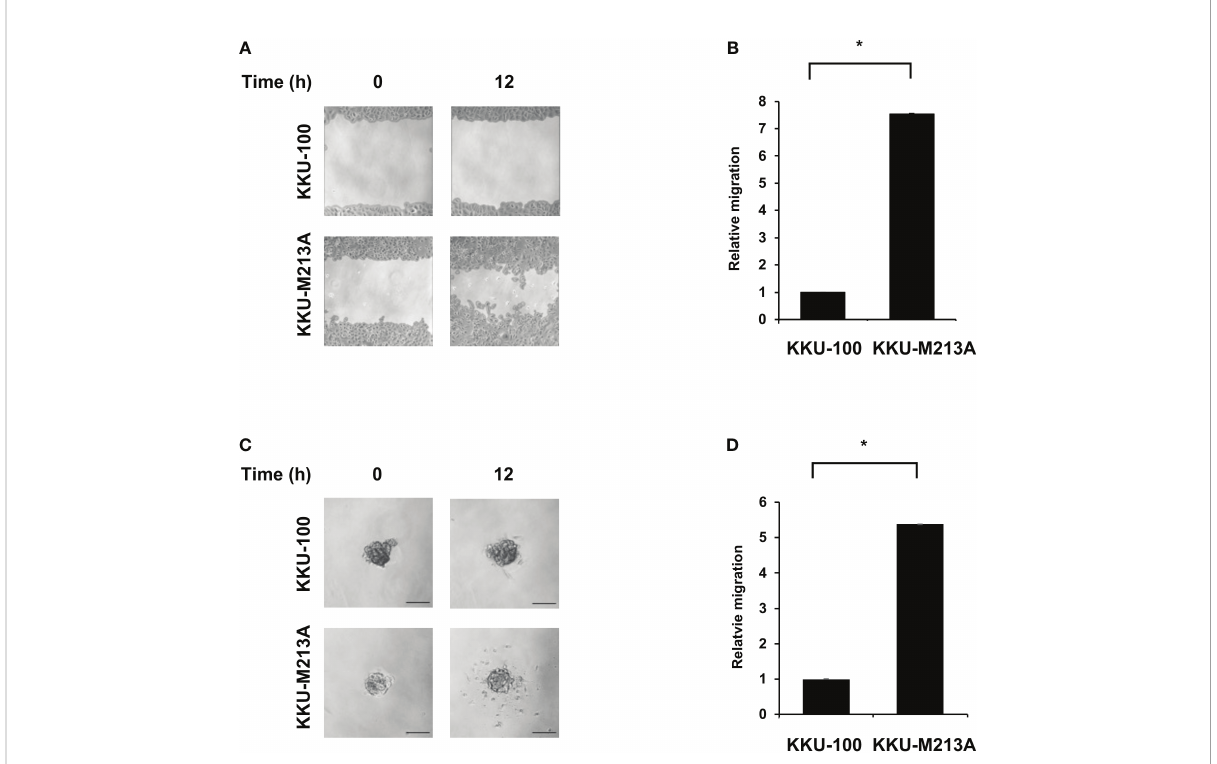
FIGURE 2 Migration activity of CCA cells in 2D and 3D cultures. KKU-100 and KKU-213A cells were grown as monolayers and spheroids for 4 days. (A) Wounds were created on CCA monolayer cells and size of the wound was photographed at 0 and 12 h following the wound scratch. (B) The relative migration is shown as the average value of migration index compared to KKU-100. (C) Representative images of 3D culture migration at 0 h and 12 h. The scale bars represent 100 m m. (D) The relative migration is represented by bar graph of the percentage migration area of KKU-213A in 3D culture compared with KKU-100. Data were presented as mean ± standard error, which were derived from three independent experiments, *p <